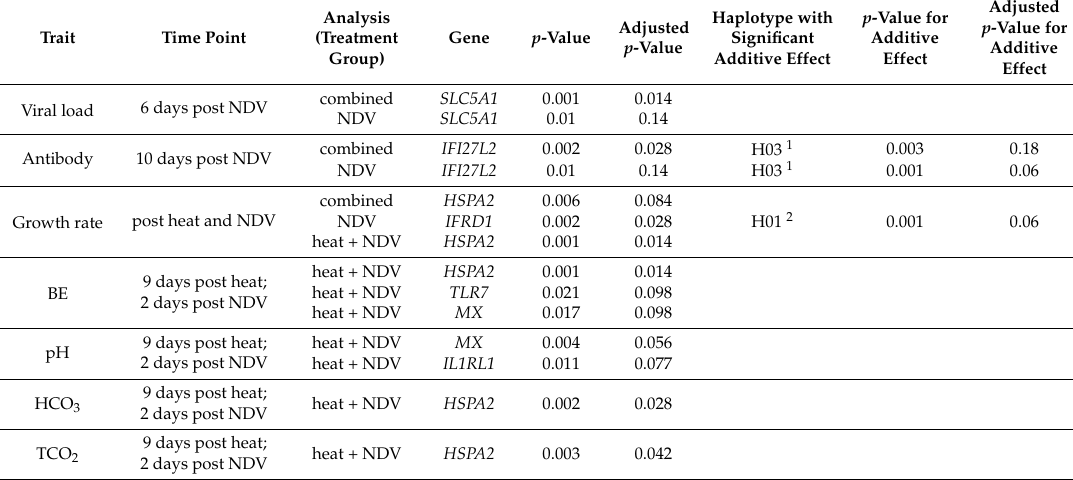
Table 3. p -values for genes with significant haplotype combination effects and for additive effects of individual